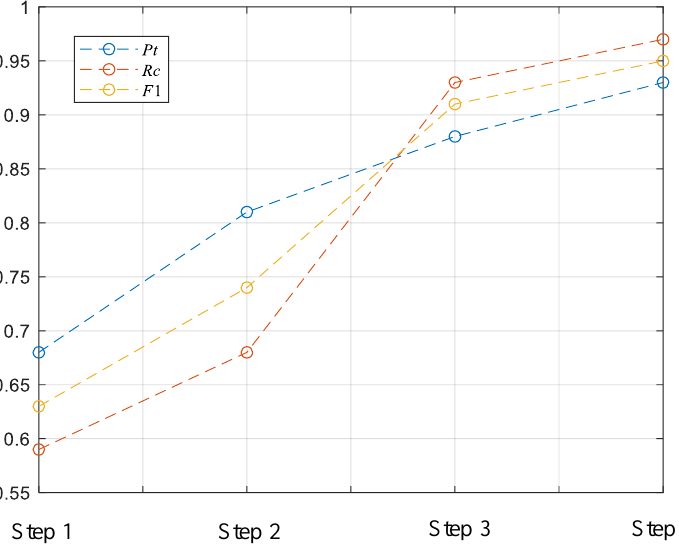
Figure 8. Calculation results in the performance of different discrimination steps of the design method in this paper.